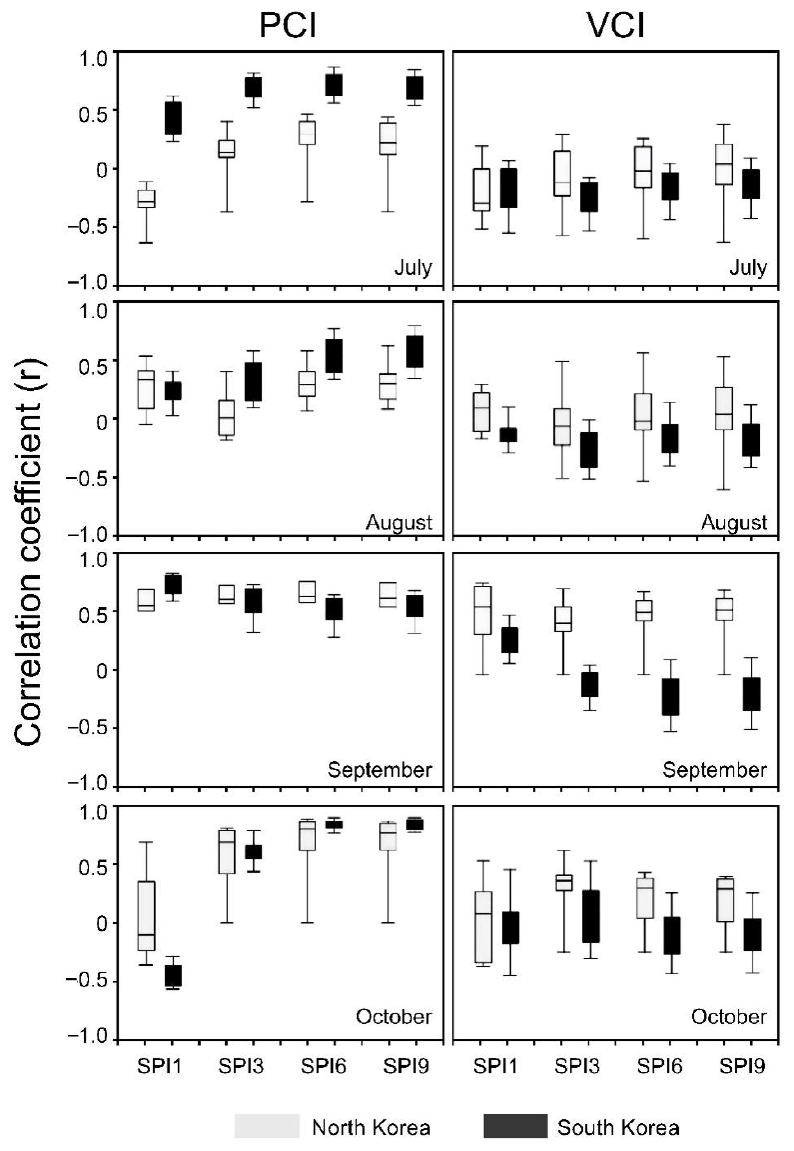
Figure 1. Boxplots of the correlation coefficients between PCI/VCI and SPIs from 61 stations.